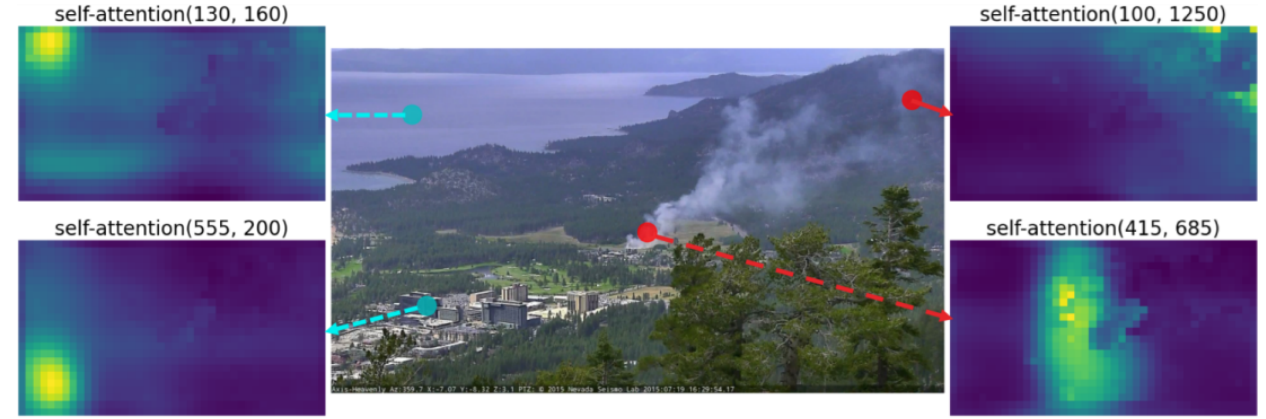
Figure 1. Encoder self-attention for a set of reference points. The example shows that the encoder is able to separate instances and regions, even at the early stages of